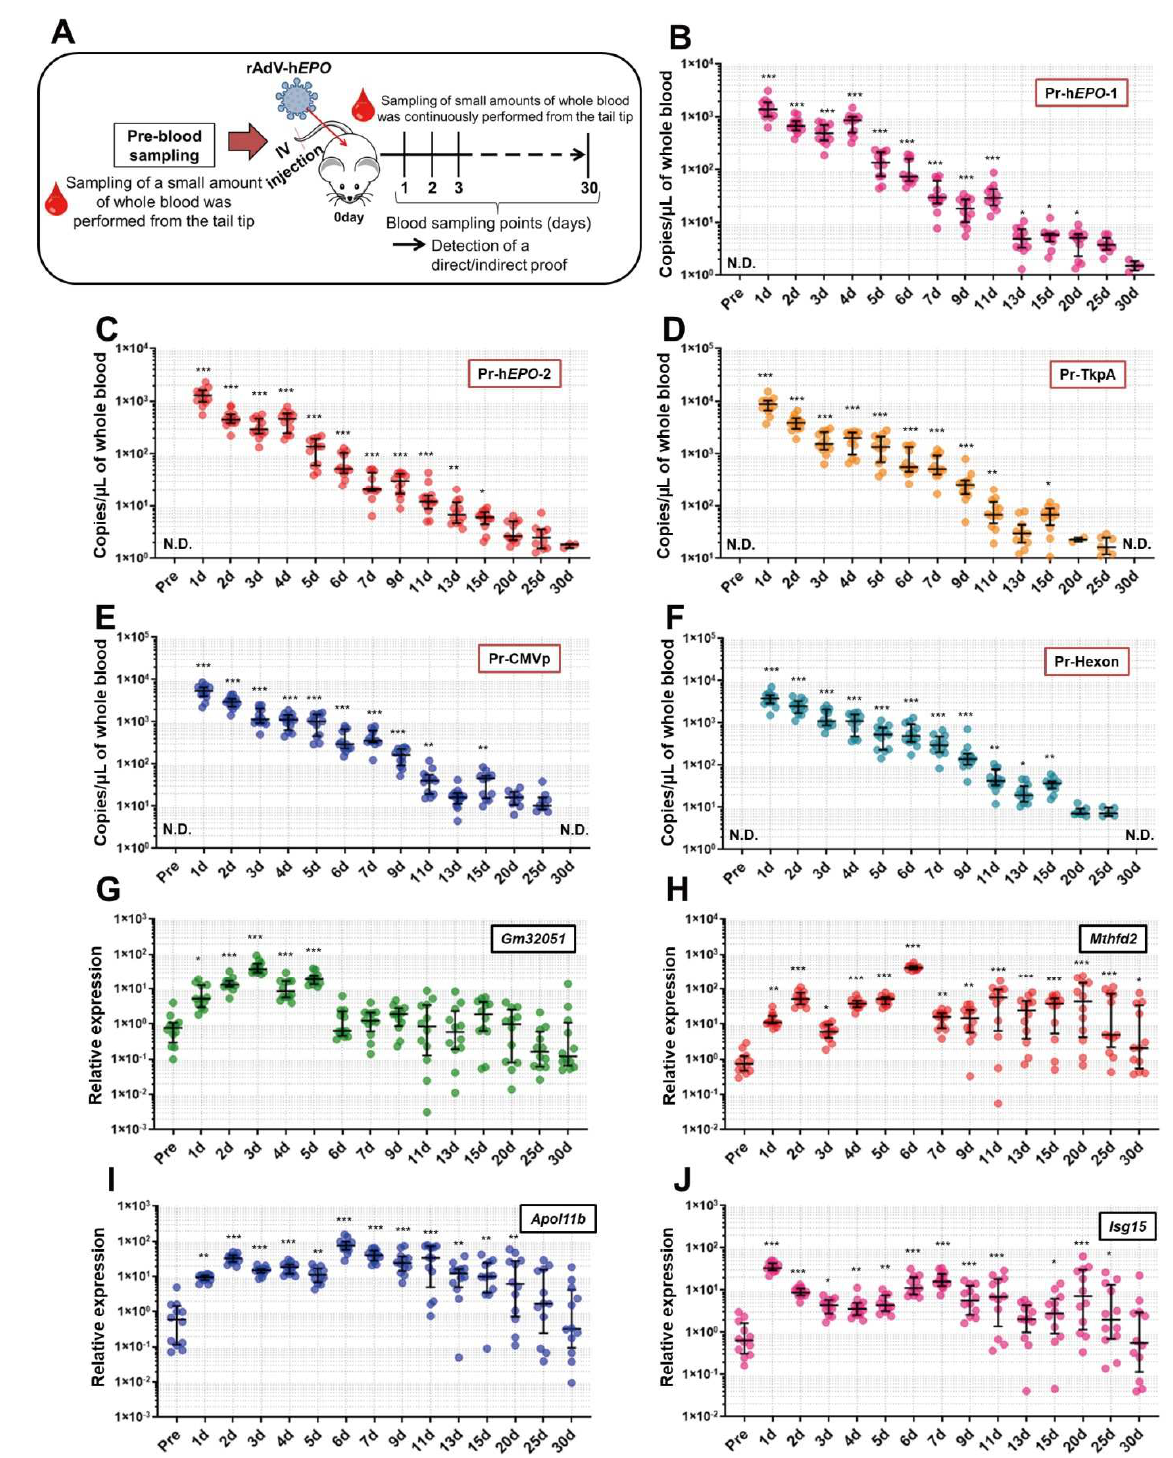
Figure 5. Detection of direct and indirect proof for a long time period. To detect direct and indirect proof, small amounts of whole blood were harvested from the tail tips of mice ( n = 12) until 30 days after the injection. From approximately 50 µL of whole blood, DNA/RNA was extracted, and the TaqMan or TB Green qPCR assays were performed to detect direct and indirect proof. ( A ) Overview of the experiments in this section, ( B – F ) continuous detection of direct proof for 30 days by five primer-probe pairs using the TaqMan qPCR assay; “Pr” refers to a primer-probe, ( G – J ): detection of changes in gene expression as indirect proof using the TB Green qPCR assay. N.D.: not detected. * p < 0.05, ** p < 0.01 and *** p < 0.001 vs.